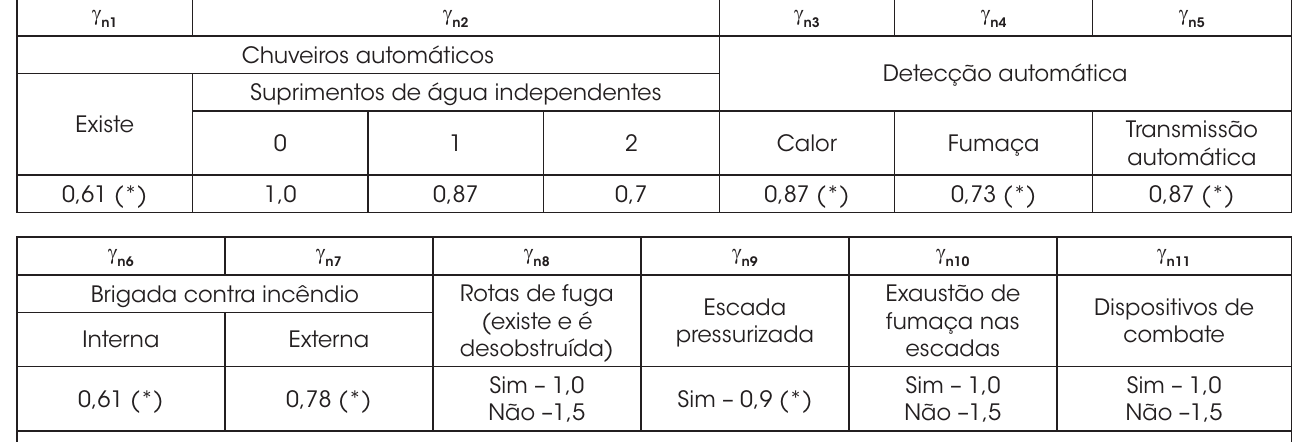
Fatores de ponderação das medidas de segurança contra incêndio (EC1, 2002)